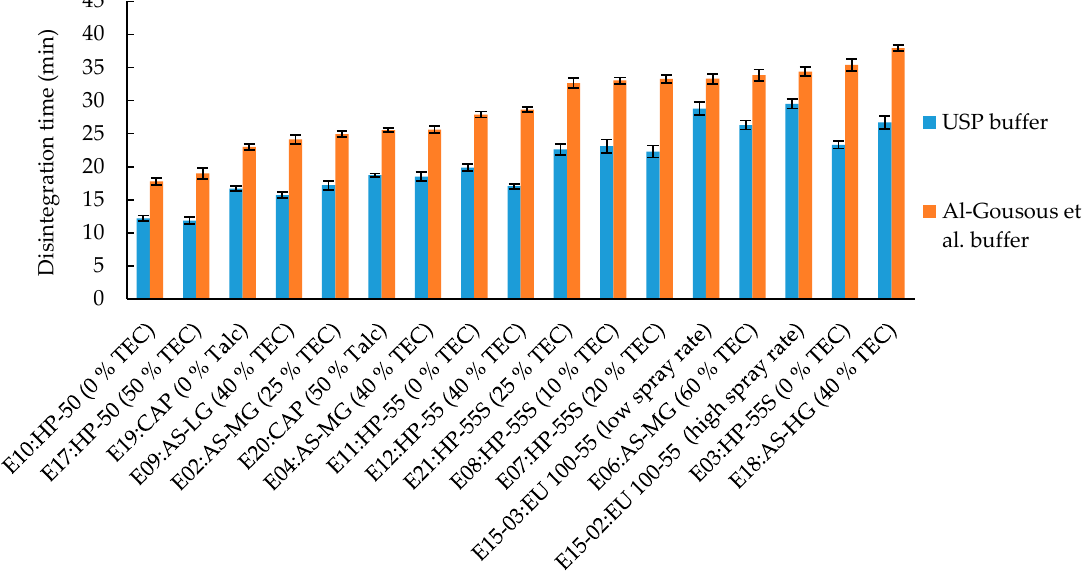
Figure 4. Disintegration times of enteric-coated capsules in 50 mM USP phosphate buffer pH 6.8 and 15 mM phosphate buffer pH 6.5 (Al-Gousous et al. buffer) without disc. Given are average disintegration times ± SD; n = 6. % TEC and talc are based on dry polymer weight.